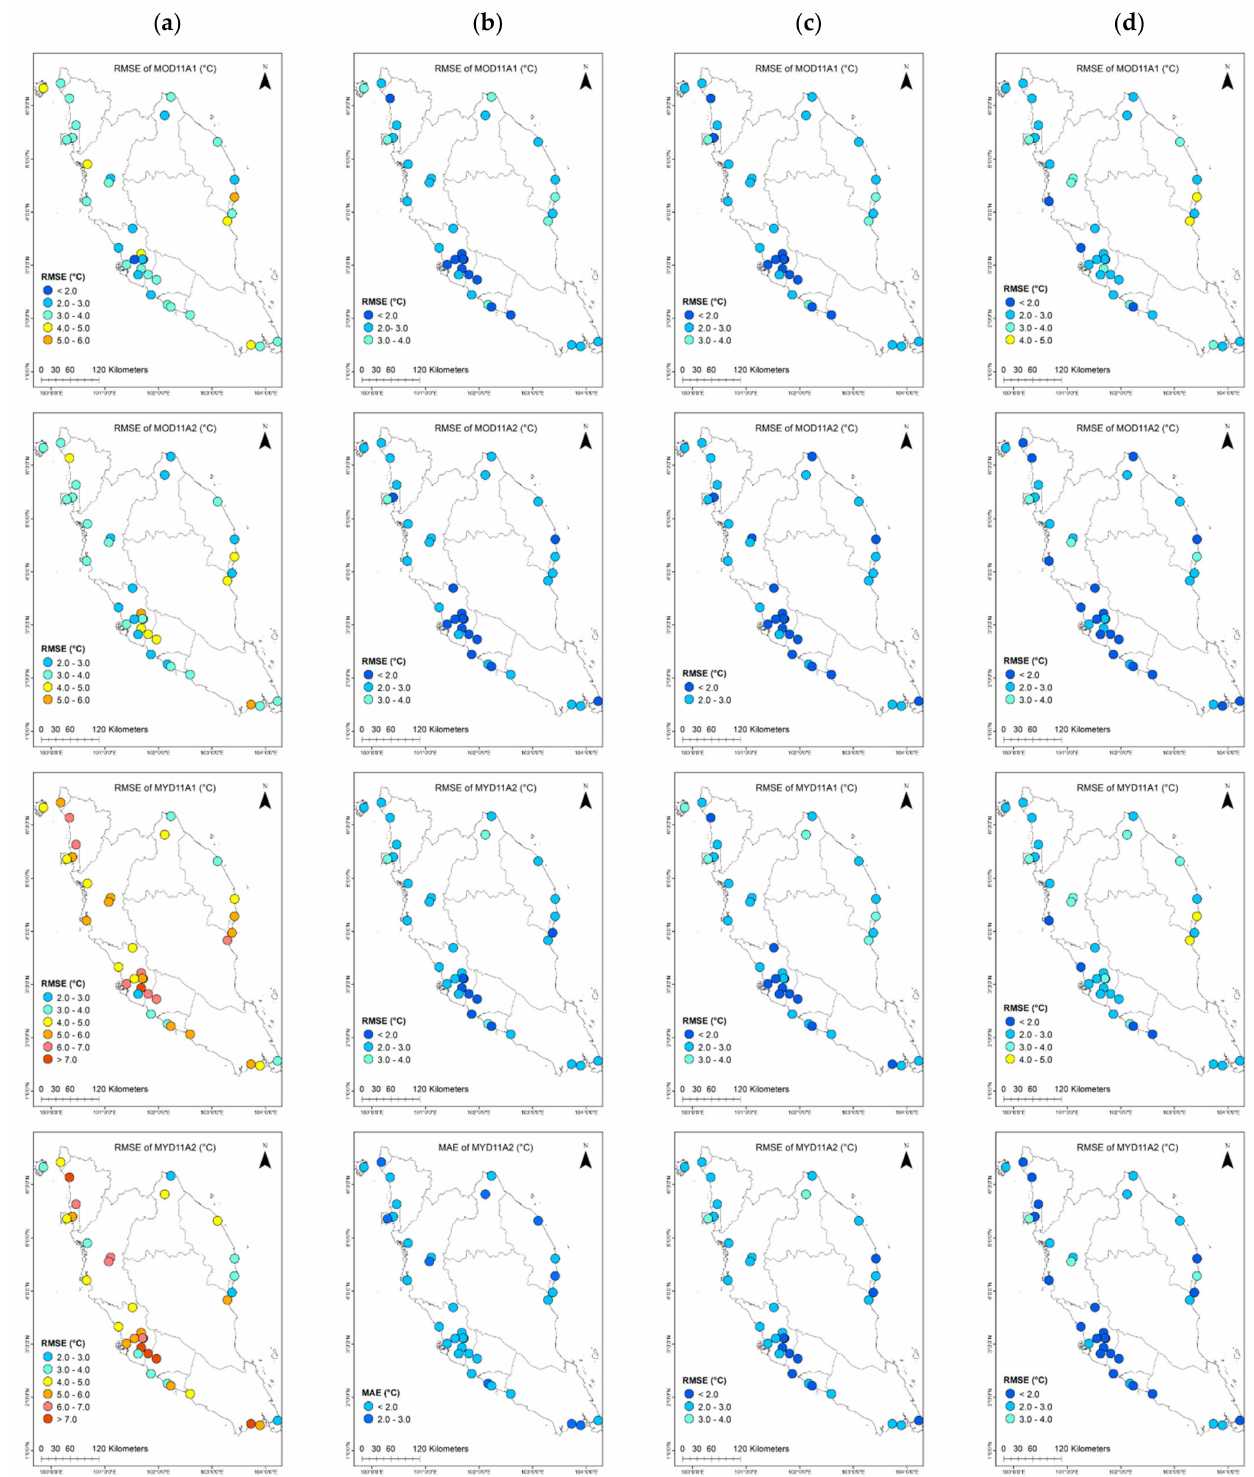
Figure 6. Distribution of RMSE for comparison between simulated data, ( a ) T s , ( b ) T scd , ( c ) T scm , and ( d ) T scq , and observed data, T a